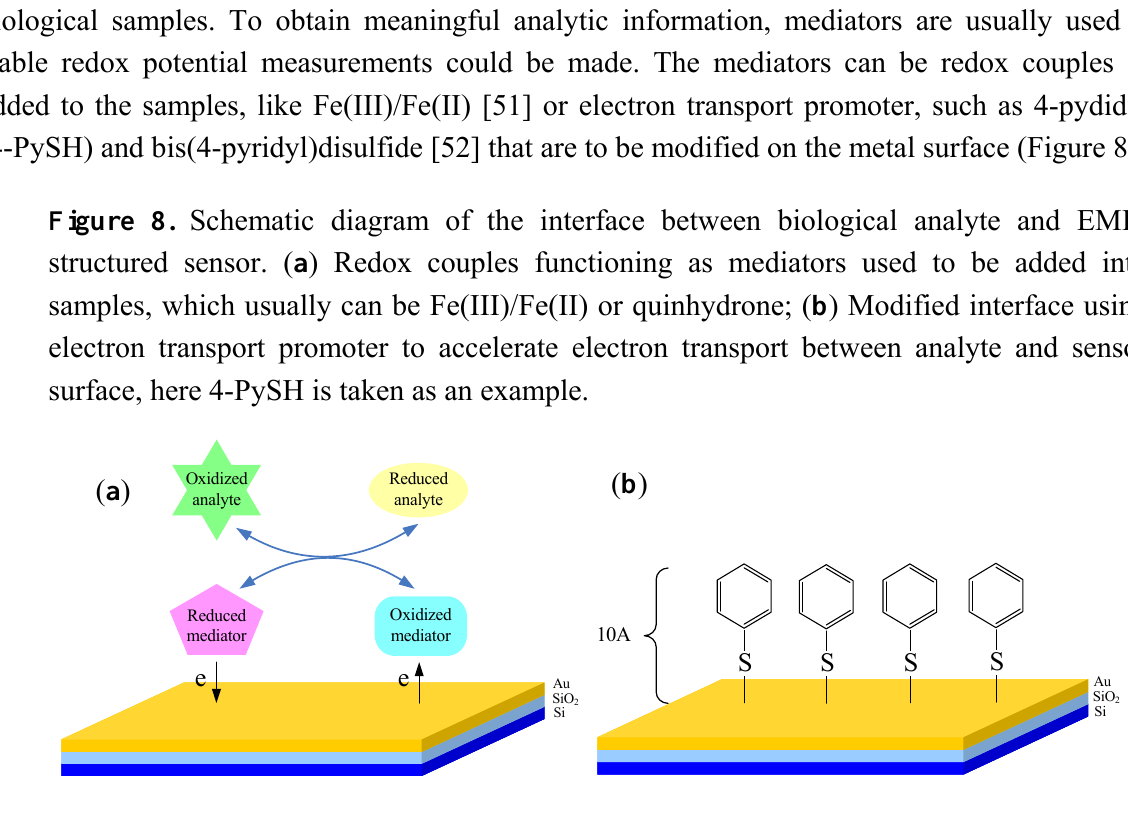
Figure 9. Fabrication process of LAPS chip: thermal oxidation, PECVD, etching, evaporating.